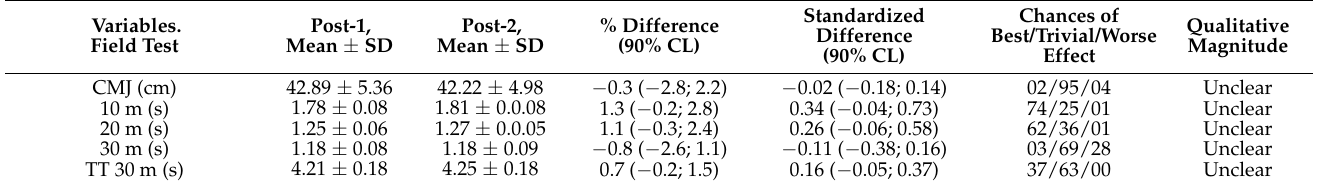
Table 2. Changes in performance after the second three-week period (post-1 to post-2) of flywheel training.